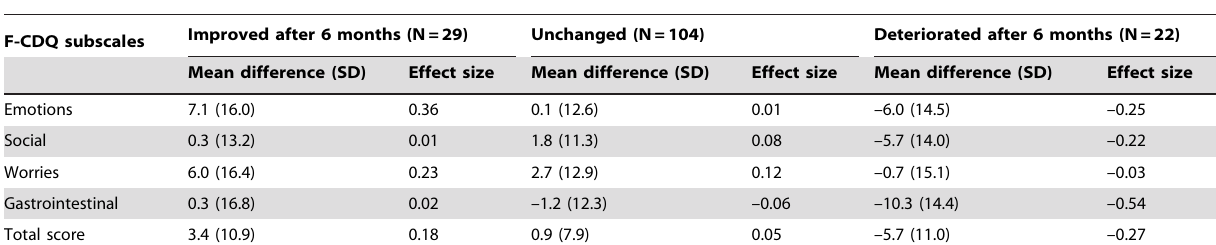
Table 6. Sensitivity to change of the French version of the ‘‘Celiac Disease Questionnaire’’ (F-CDQ).